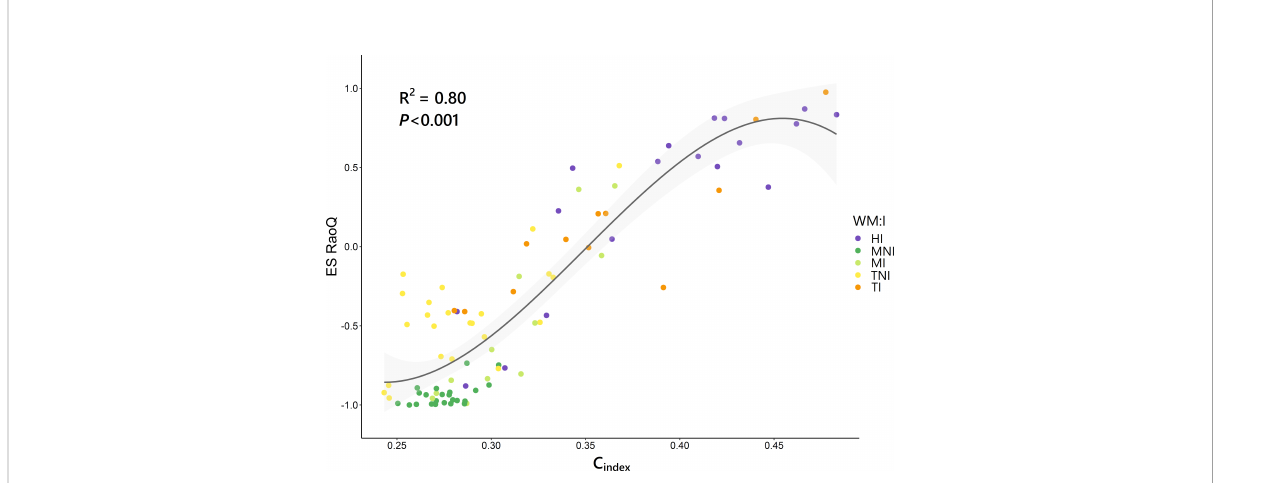
FIGURE 5 Relationship between competitiveness index (C index ) and the effect size of RaoQ (ES RaoQ). Dots, corresponding to plots, have been fi lled in by the interaction of weed management and irrigation (WM:I): HI, herbicide – irrigation; MNI, mowing – non-irrigation; MI, mowing – irrigation; TNI, tillage – non-irrigation; TI, tillage – irrigation. R-squared ( R 2 ) provides the proportion of variance explained by C index . Con fi dence intervals (95%) are shaded in light gray.